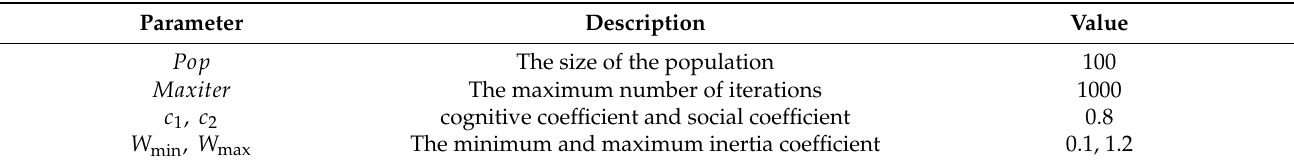
Table 2. NSPSO algorithm parameters and